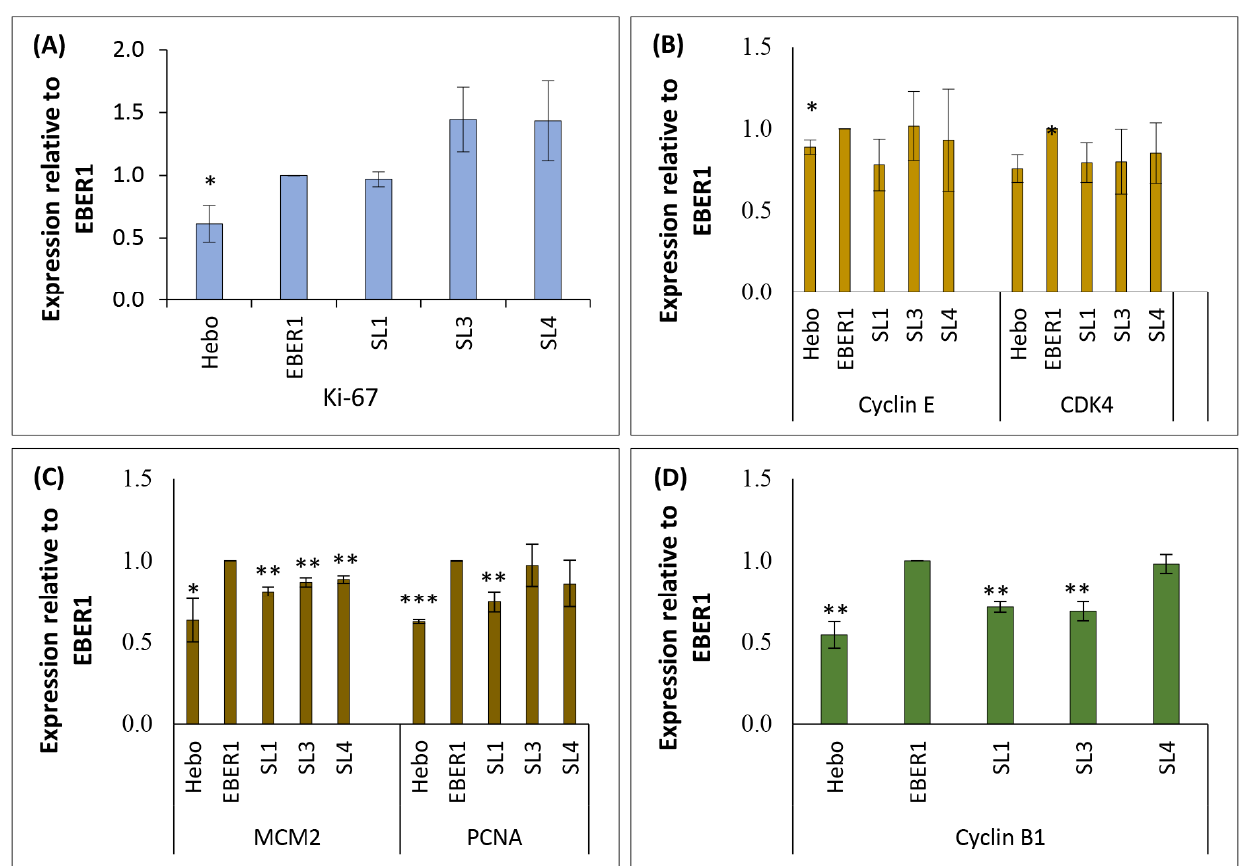
Figure 8. Quantitative expression of genes associated with cell cycle progression . Total cellular RNA was isolated using TRIzol method, and a total of 5 µ g was reverse transcribed to cDNA. A total of 100 ng was amplified in a qRT-PCR reaction for the quantification of cell cycle genes. ( A ) Pan cell cycle marker. ( B ) Genes expressed in G0/G1 phase. ( C ) Genes expressed in S phase. ( D ) Genes expressed in G2/M phase. Each experiment was performed in duplicate and repeated three times. Data were expressed as mean ( ± SEM) of the three independent experiments. * = p ≤ 0.05, ** = p ≤ 0.01, and *** = p ≤ 0.001.